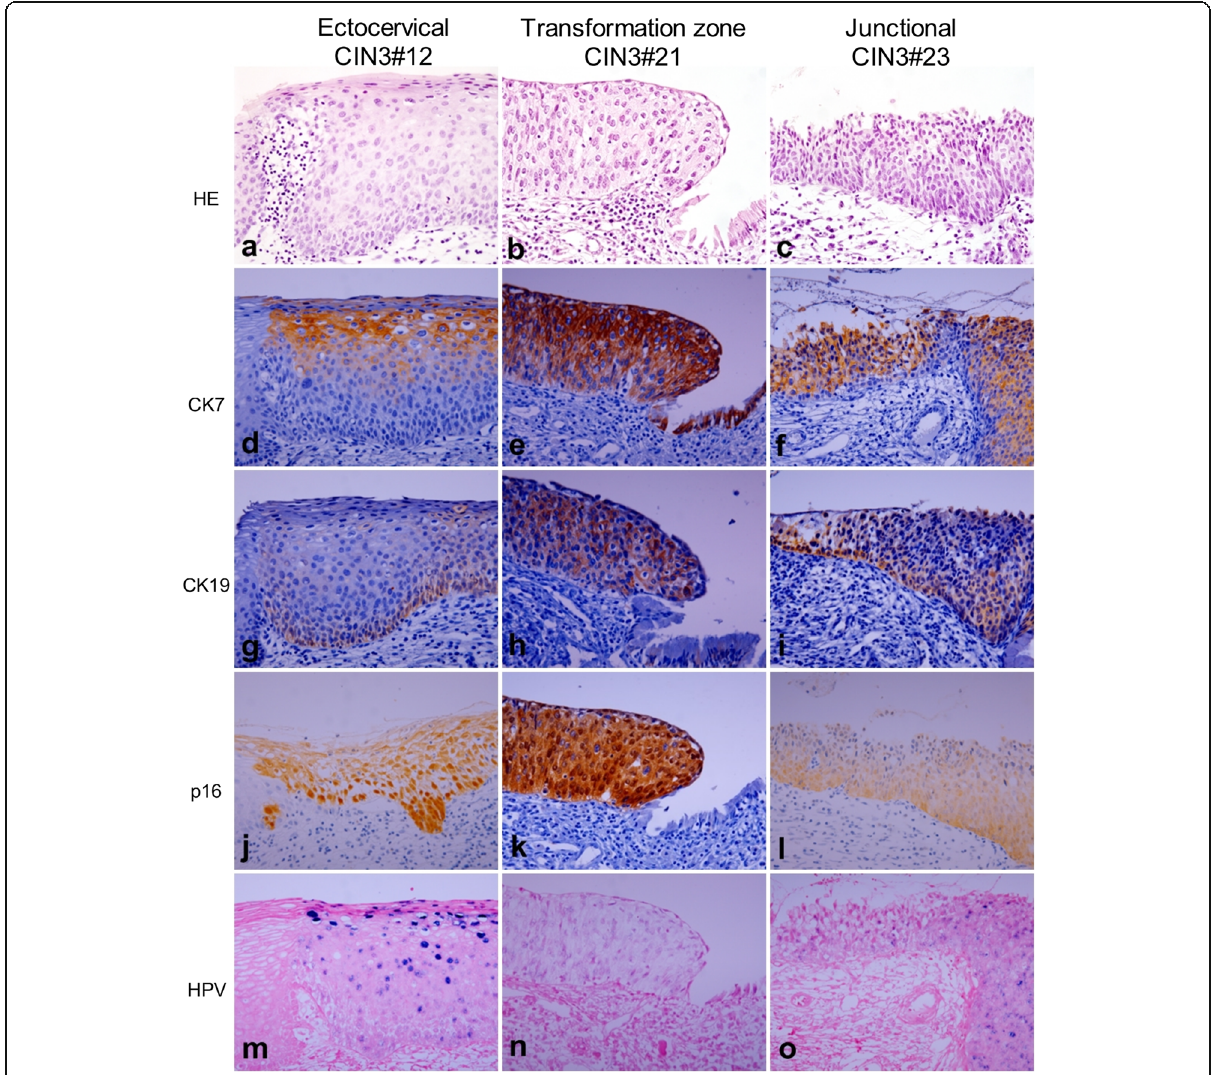
Fig. 4 Expression pattern of CK7, CK19, p16, and HR HPV in CIN3. HE staining shows representative CIN3s developing in the ectocervix (CIN3#12) ( a ), transformation zone (CIN3#21) ( b ), and SCJ (CIN3#23) ( c ), respectively. CIN3#12 shows patchy staining of CK7 in the upper layer ( d ), patchy staining of CK19 in the lower layer ( g ), diffuse staining of p16 ( j ), mixture of episomal and integrated HPV with remarkable episomal form in the upper layer ( m ). CIN3#21 and CIN3#23 show diffuse staining of CK7 ( e and f ), CK19 ( h and i ), and p16 ( k and l ). HPV is present in integrated form in CIN3#21 ( n ) and mixed episomal and integrated form in CIN3#23 ( o ). Original magnifications: